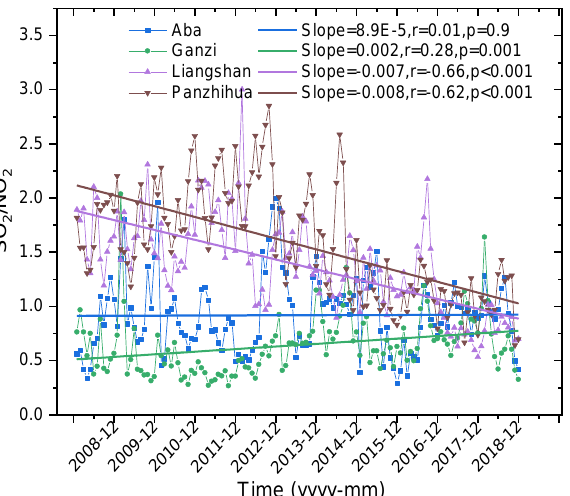
Figure 5. Variations of concentration ratio of SO 2 to NO 2 in Aba, Ganzi, Liangshan, and Panzhihua from 2008 to 2018.